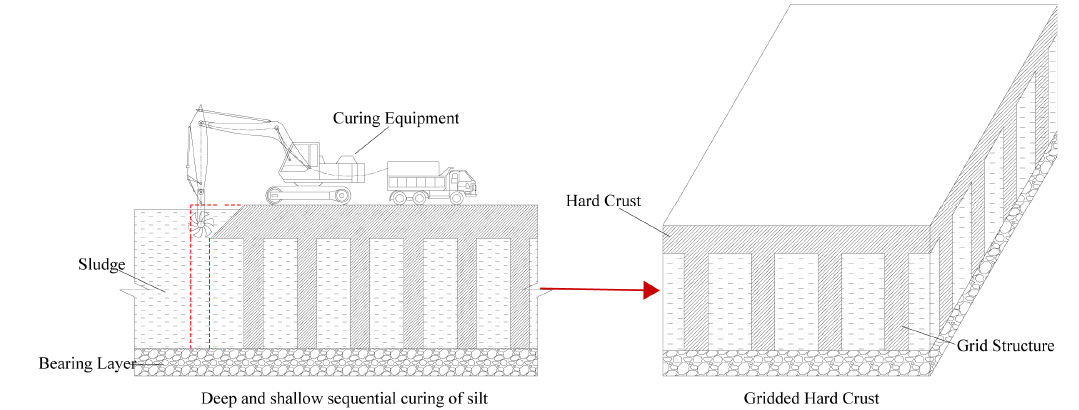
Figure 1. Gridded hard crust construction process.